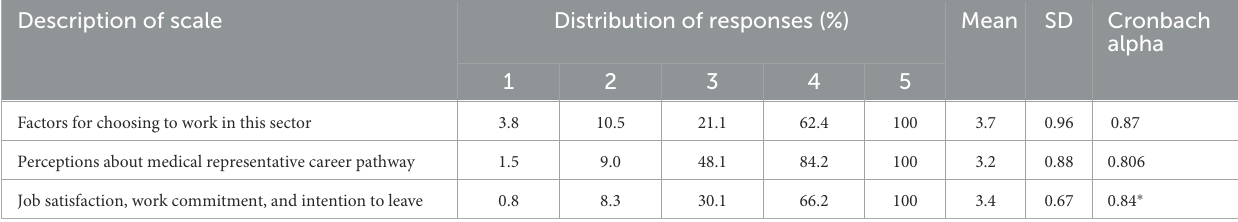
TABLE 5 Distribution and internal consistency of overall scales. Description of